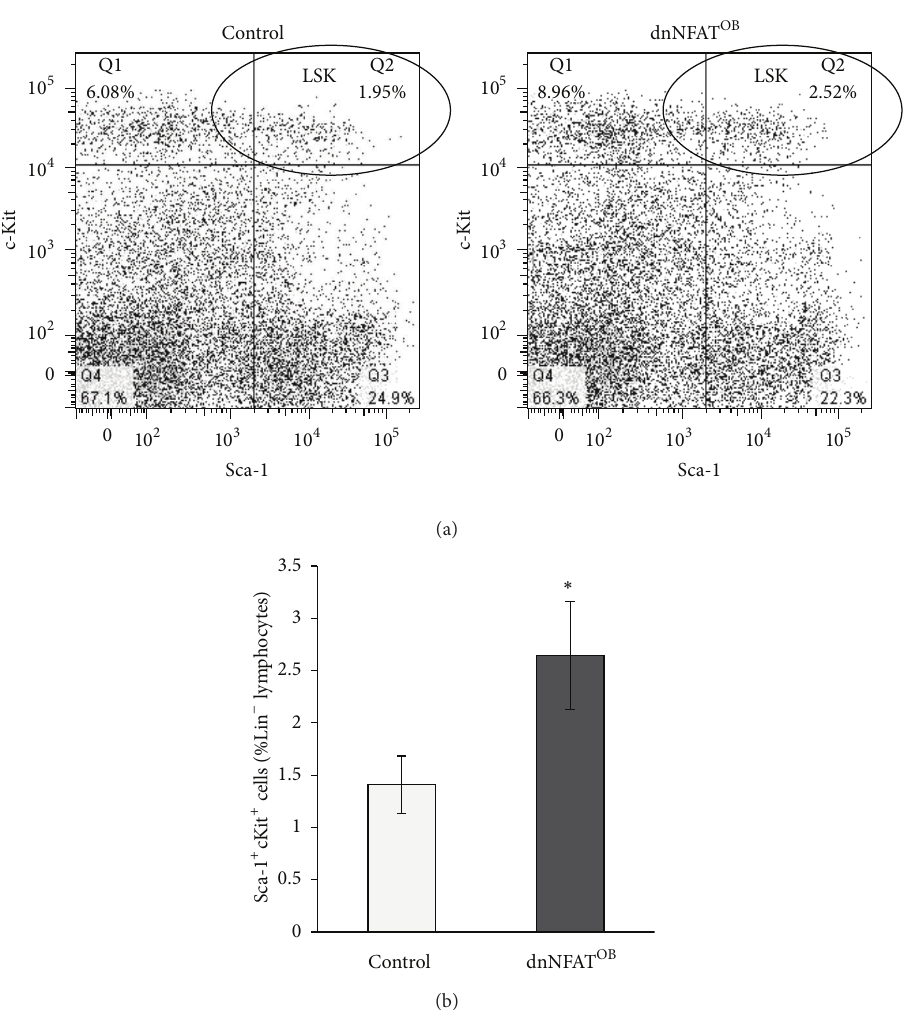
Figure 3: Lin − Sca1 + cKit + (LSK) hematopoietic stem/progenitor cells are increased in dnNFAT OB mice. Bone marrow was flushed from tibiae and femora of 12-week-old control and dnNFAT OB mice and analyzed by flow cytometry for detection of LSK cells. (a) Representative dot plots from control and dnNFAT OB mice showing c-Kit + Sca-1 + cells gated from the Lin − cell population. (b) Percentages of LSK cells were analyzed from control ( 𝑛 = 8 ) and dnNFAT OB ( 𝑛 = 7 ) mice. Mean indicated by black bar; ∗ 𝑃 < 0.05 when compared to the